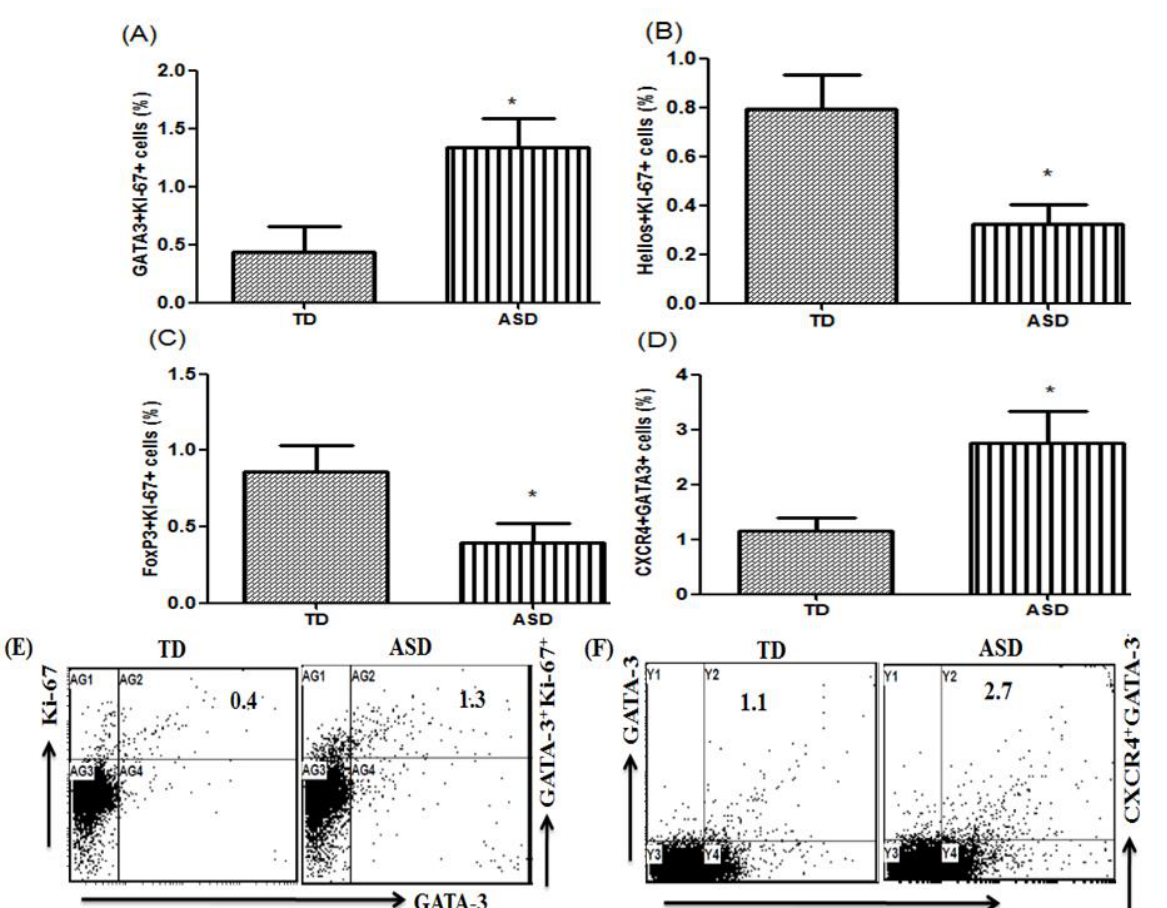
Figure 4. Ki-67 expression in GATA3+, Helios+, and FOXP3+ peripheral blood mononuclear cells (PBMCs). ( A – C ) Flow cytometric analysis of intracellular Ki-67-producing GATA3+, Helios+, and FOXP3+ PBMCs in children with autism spectrum disorder (ASD) and typically-developing (TD) controls. ( D ) Flow cytometric analysis of GATA-3 production in CXCR4+ cells. ( E , F ) Representative flow cytometry dot plots showing the percentage of Ki-67-producing GATA3+ and CXCR4+GATA3+ PBMCs from TD controls and children with ASD. Statistical analysis was carried out by Student’s t -test. Statistical significance was determined as * p < 0.05.